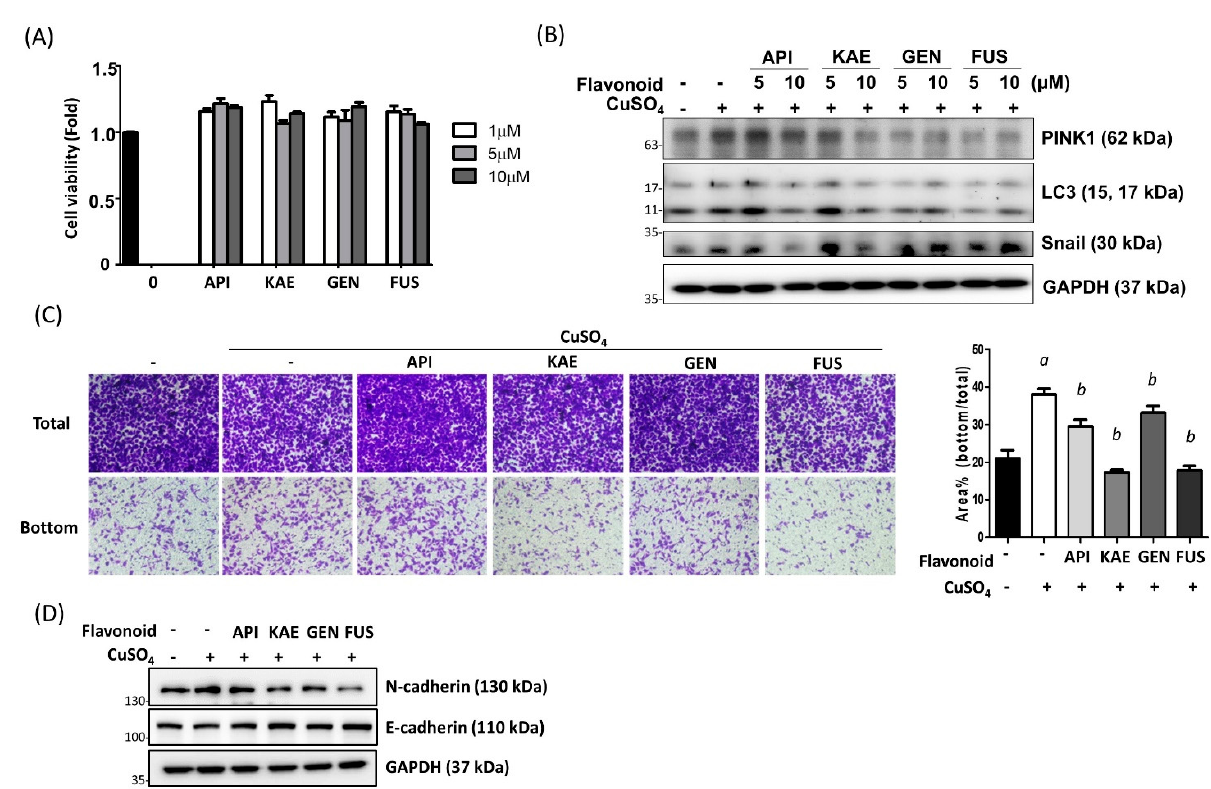
Figure 5. Flavonoid reversed CuSO 4 -induced EMT changes. ( A ) A549 cells were treated with 1 µ M, 5 µ M, and 10 µ M of flavonoids (API: apigenin, KAE: kaempferol, GEN: genkwanin, FUS: fustin) for 24 h. After treatment, the cell viability was determined by CCK-8 assay. Mean ± SEM, ( B ) A549 cells were pre-treated with flavonoids for 2 h followed by combined treatment of 10 µ M CuSO 4 for 3 h. The protein expressions were determined by Western blot against PINK1, LC3, and Snail. GAPDH served as internal control. ( C ) A549 cells were pretreated with various flavonoids (10 μ M) for 2 h followed by combined treatment with CuSO 4 for 24 h. After treatment, the cells were harvested and re-plated into a trans-well. 24 h after incubation, the cells were fixed and the total and bottom cells are images to determine the migration activity. The quantitative results are shown in right panel. Mean ± SEM. a : significant compared with control group. b : significant compared with CuSO 4 group. ( D ) The protein expression of EMT markers N-Cadherin and E-Cadherin were examined by Western blot. All experiments were performed three times and the representative images are shown.